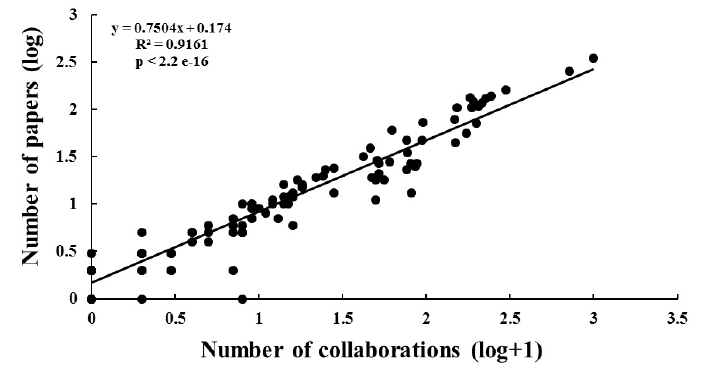
Figure 5. Number of papers published in function of the number of collaboration. Regression model between collaboration number and papers